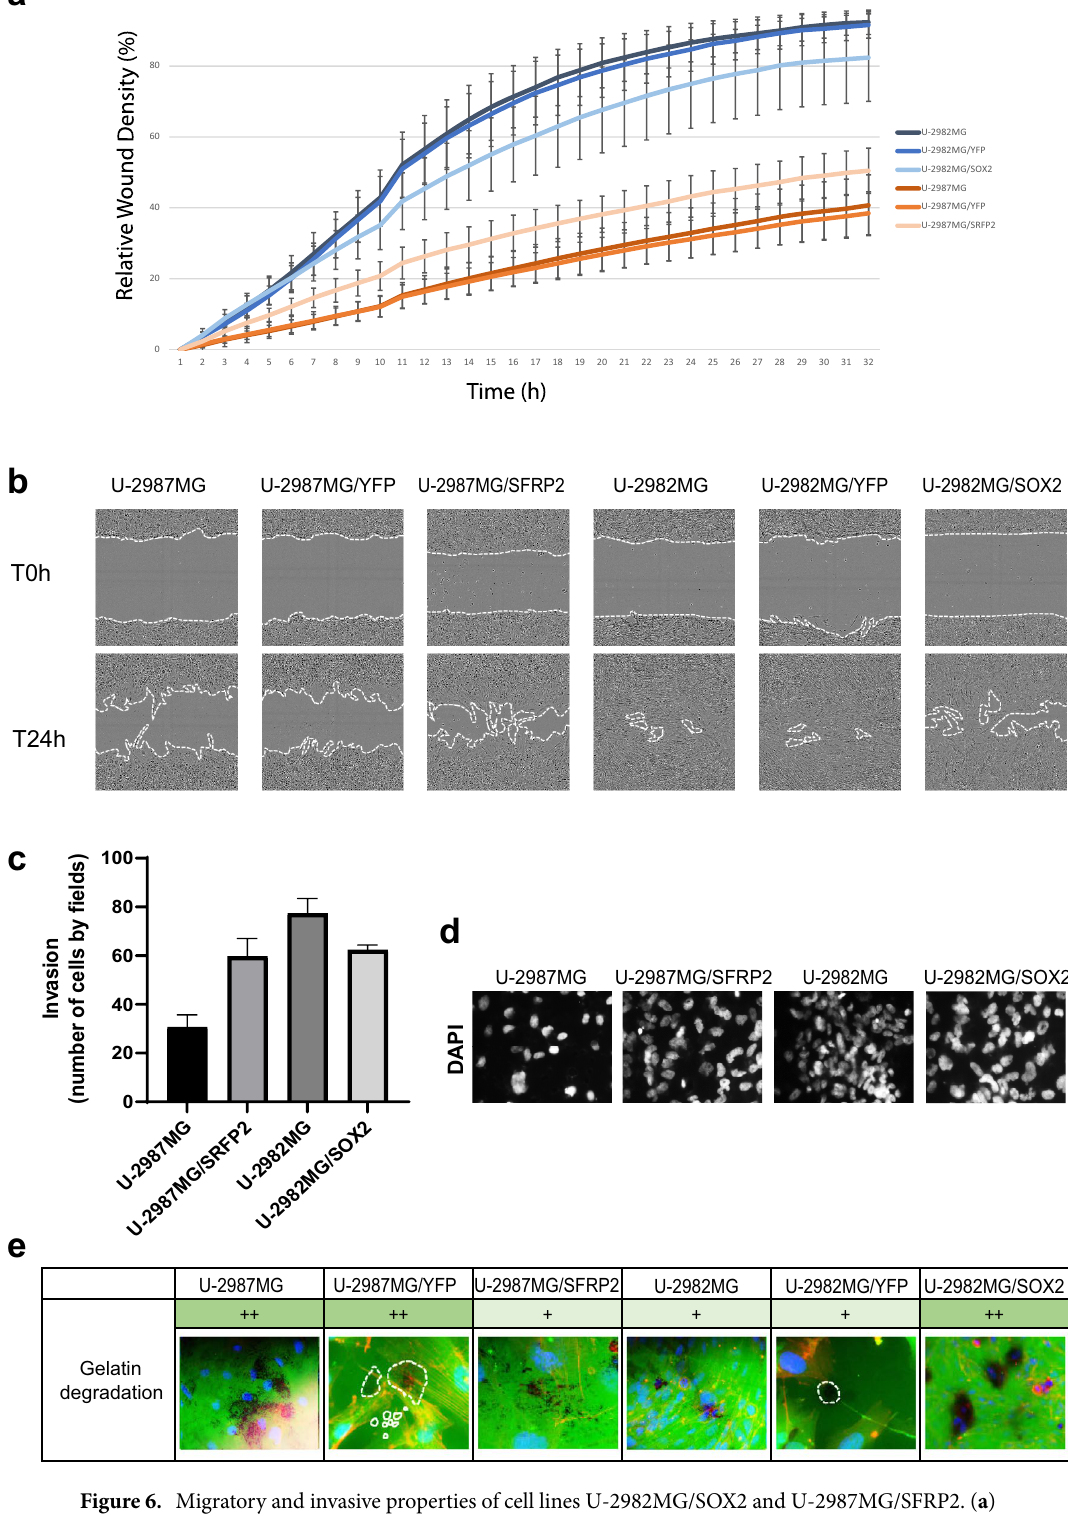
Figure 6. Migratory and invasive properties of cell lines U-2982MG/SOX2 and U-2987MG/SFRP2. ( a ) Quantification of wound closure over 48 h, using the IncuCyte imaging device to track live-cell motility. ( b ) Representative images of wound closure in the cell lines, at t = 0 h and after 24 h. ( c ) Quantification of invasion using cell migration through Transwell filters coated with Collagen 1. Statistical significance was calculated with ANOVA-Tukey’s post-hoc tests and summarized in Supplementary Table S12. ( d ) Representative images of invasive cells on the lower face of the membrane, as stained with DAPI. ( e ) Representative images of matrix degradation activity 48 h after seeding the cells on coverslips coated with FITC-labeled gelatin, with degradation activity from 0 (no degradation) to + + + (high